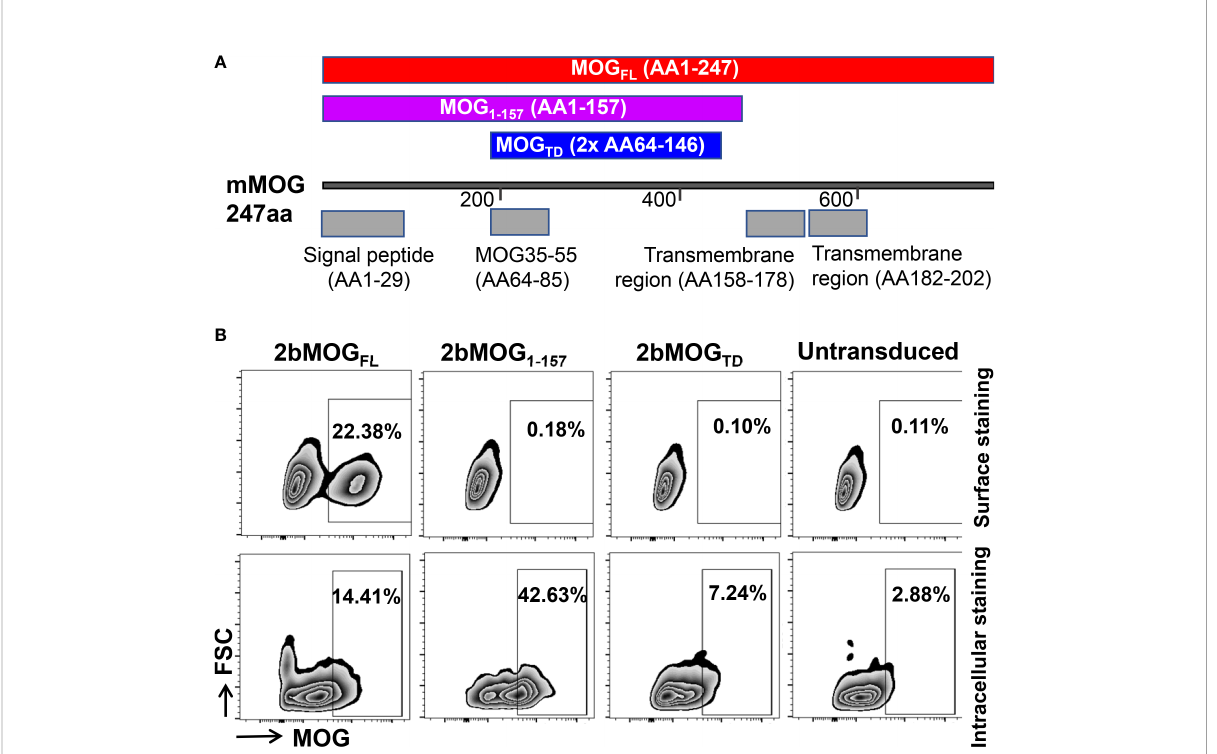
FIGURE 1 Generation and evaluation of platelet-speci fi c MOG expression lentiviral vectors. (A) Schematic diagram of MOG TD , MOG 1-157 , and MOG FL expression cassettes. Each MOG expression cassette was placed under the control of the platelet-speci fi c a IIb promoter. (B) MOG expression in a promegakaryocyte cell line, Dami cells. Lentiviral vectors harboring the 2bMOG TD , 2bMOG 1-157 , or 2bMOG FL expression cassette were produced by transient transfection of HEK293 cells. Dami cells were transduced with lentiviruses. After 72 hours of culture, cells were stained with anti-MOG antibody with or without permeabilization and analyzed by fl ow cytometry. Representative fi gures from fl ow cytometry analysis are